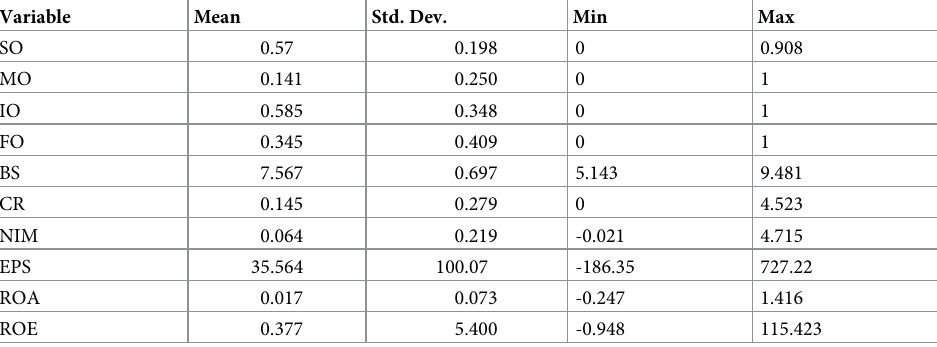
Table 2. Descriptive statistics.